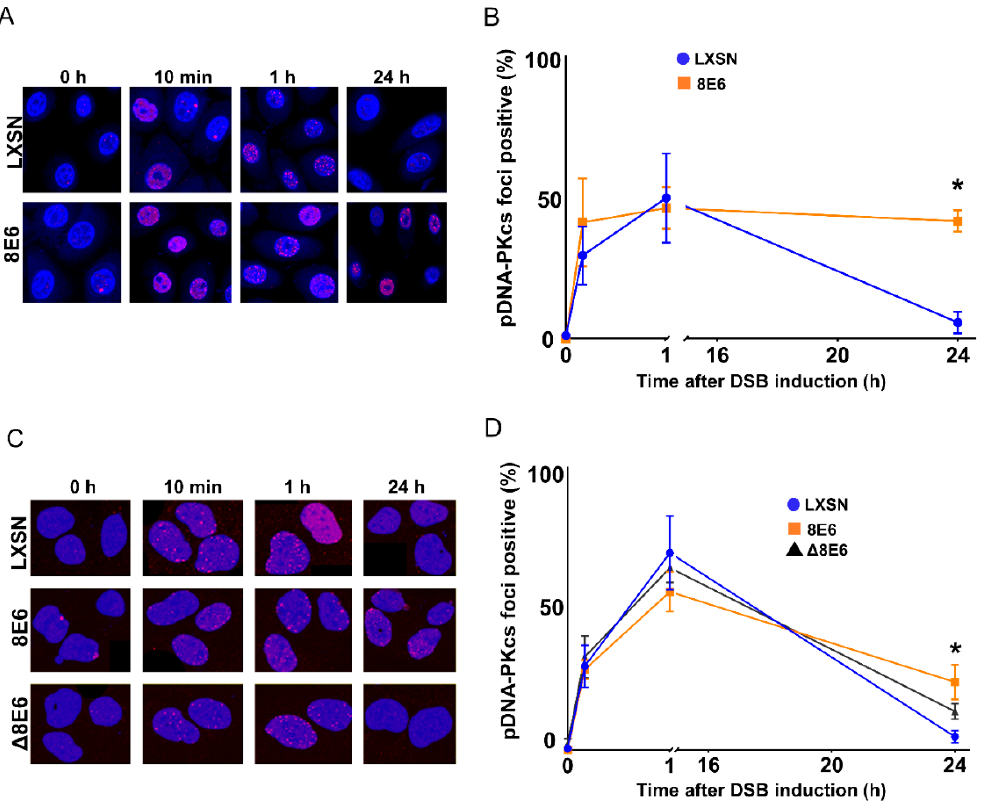
Figure 4. β -HPV 8E6 increases pDNA-PKcs foci persistence. Immunofluorescence microscopy was used to detect pDNA-PKcs foci in cells that were treated with Zeocin. ( A ) Representative images of pDNA-PKcs foci in HFK cell lines, following treatment with Zeocin for 10 mins. ( B ) Percentage of pDNA-PKcs foci positive ( > 2) cells following Zeocin exposure. ( C ) Representative images of pDNA-PKcs foci in U2OS cell lines treatment with Zeocin for 1 h, then harvested 0 h, 10 min, 1 h, and 24 h after Zeocin treatment. ( D ) Percentage of pDNA-PKcs foci positive ( > 4) U2OS cells following Zeocin exposure. All values are represented as mean ± standard error from at least three independent experiments. Statistical di ff erences between groups were measured by using Student’s t -test. * indicates p < 0.05. All microscopy images are 400X magnification.